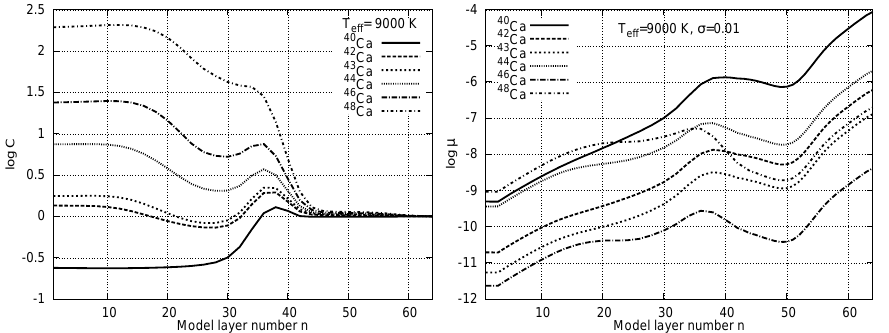
Fig. 4. The same as in Fig. 1, but for T eff = 9 000 K. The mean value of the impact cross section is (cid:27) = 0 : 01 (cid:1) 10 (cid:0) 16 cm 2